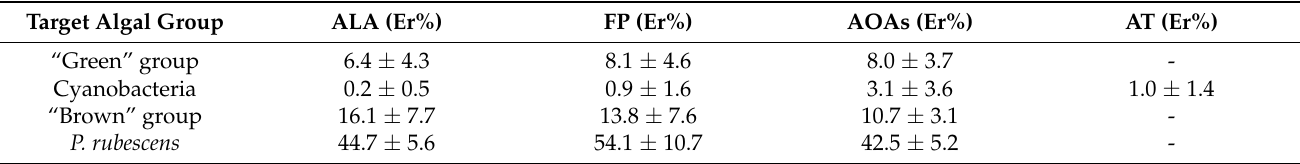
Figure 3. Performance evaluation of the three models of the probes (i.e., ALA, FP, and AOAs) in terms of coefficient of variation between probes’ determination of Chl- a and the means of all of the extraction methods (CV%) and accuracy in targeting the correct algal group (Acc%). Both CV(%) and Acc(%) were calculated for each algal group: “green” group, Cyanobacteria, and “brown” group, and for all samples, i.e., “General”. Table 3. Misattribution rate of each spectrofluorometer in targeting the correct algal group on monospecific cultures, calculated as percent error (Er%). Data reported are based on all simultaneous tests performed and joined together based on the target algal group. AT provides total and cyanobacterial Chl -a ; thus, the percent error was only reported for Cyanobacteria.